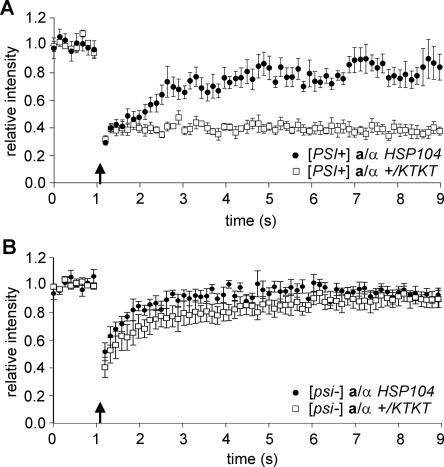
Hsp104 Inhibition Renders Sup35-GFP[PSI+] Complexes Immobile(A) FRAP time courses for Sup35-GFP[PSI+] in wild-type (SY360 × SY581; black circles) and in +/KTKT (SY893 × SY581; white squares) zygotes are shown (n = 6). The recovery half-time for the wild-type zygote is 0.92 s (R2 = 0.85).(B) FRAP time courses for Sup35-GFP[psi−] in wild-type (SY360 × SY582; black circles, n = 5) and in +/KTKT (SY893 × SY582; white squares, n = 6) zygotes are shown. The recovery half-time for the wild-type zygote is 0.47 s (R2 = 0.85) and for the +/KTKT zygote is 0.7 s (R2 = 0.89). The black arrow marks the bleach point. Error bars represent standard error of the mean.